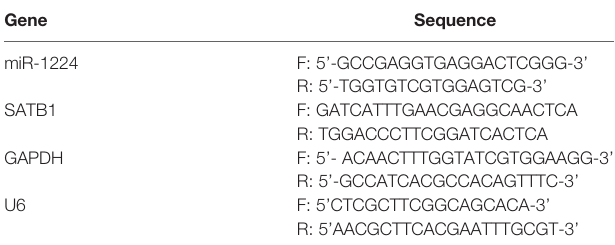
TABLE 1 | Primer sequences used for quantitative real-time